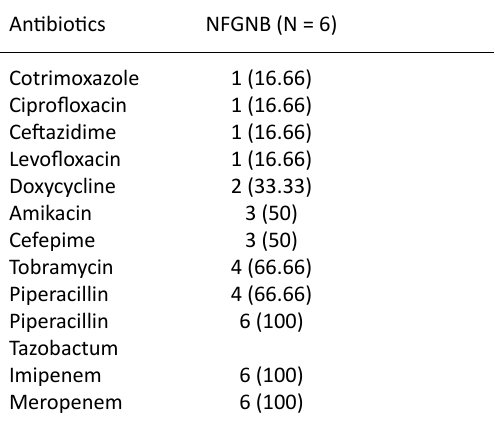
table 3. Antibiotic sensitivity pattern of Gram negative bacteria isolated from ICU